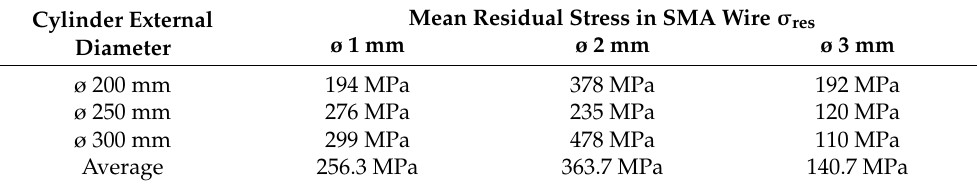
Table 7. Mean values of residual stress in SMA wire at the residual state σ res